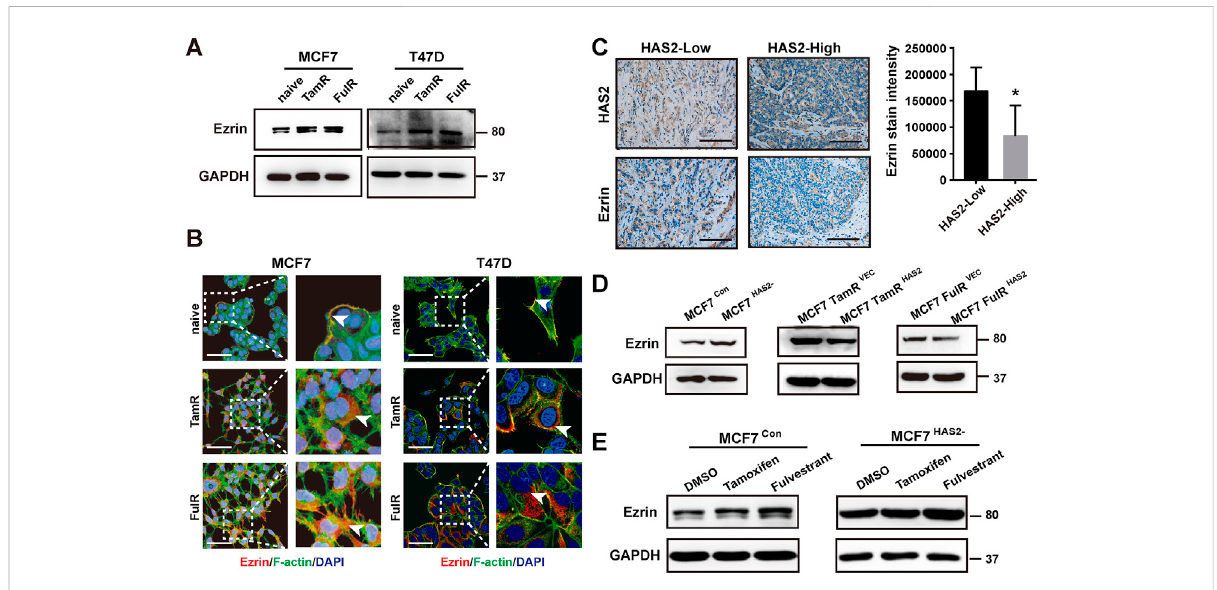
FIGURE 3 HAS2 decrease upregulated Ezrin expression in response to antiestrogens in ER + breast cancer cells. (A) Immunoblotting analysis of Ezrin expression was performed in sensitive and resistant cells as indicated. (B) The levels of Ezrin in endocrine-resistant MCF7 and T47D cells were observedbyimmuno fl uorescence. CellswerestainedwithEzrinantibody(red),Phalloidin-iFluor488reagentforF-actin (green),andDAPIfornuclei (blue). Scale bars, 50 µm. (C) The levels of Ezrin and HAS2 in ER + human breast cancer tissues were evaluated by immunohistochemistry. Signi fi cant (* p < 0.05, Mann-Whitney test) decrease of Ezrin staining was observed in HAS2 high breast cancer patients ( n = 7) compared with HAS2 low patients ( n = 5). (D) The changes of Ezrin levels in naïve MCF7 cells with HAS2 knockout and endocrine-resistant MCF7 cells with HAS2 overexpression. (E) MCF7 cells with or without HAS2 knockout were stimulated by tamoxifen or fulvestrant (1 μ M) for 3 days. Then the expression of Ezrin was analyzed by western